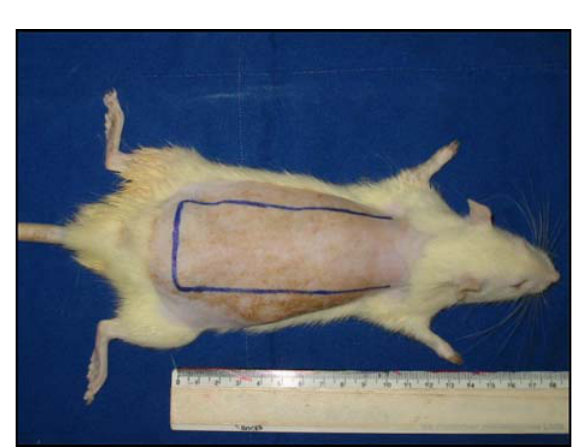
FIGURE 1 - Planning flap in pattern sizes